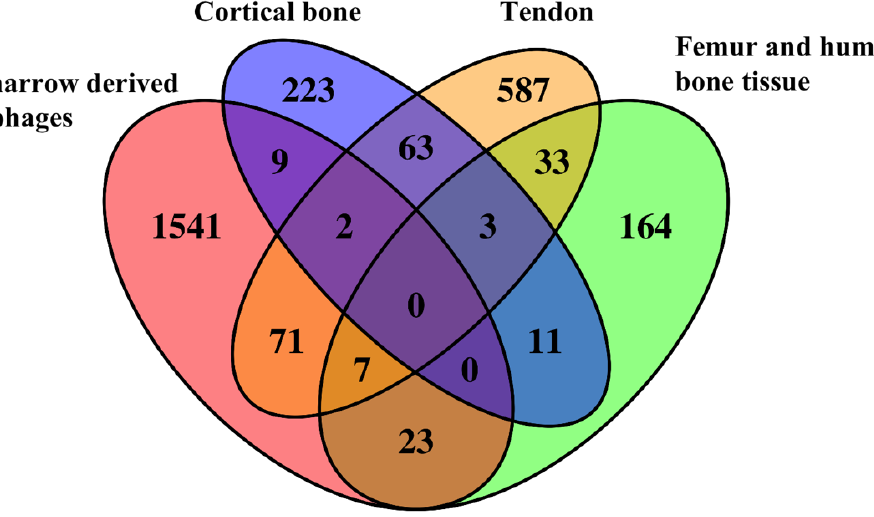
Figure 2. Overlapping DEG distribution in tendon, femur and humerus bone tissue, cortical bone, and bone-marrow-derived macrophages. Table 3. List of the most overlapping DEGs in Piezo1 mutant tissues.